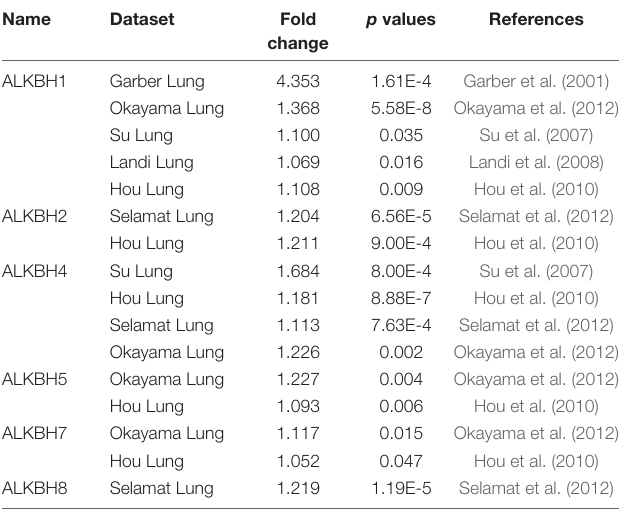
TABLE 1 | The expression profiles of the AlkB family in patients with LUAD using the Oncomine